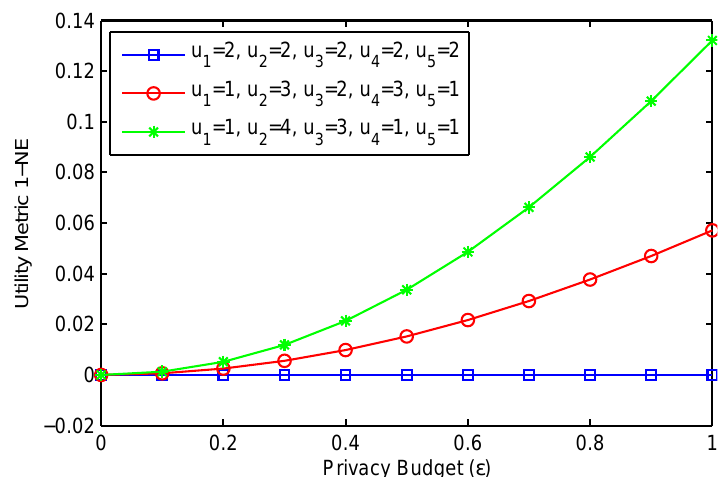
Figure 8. Utility metric 1 − NE of output of exponential mechanism.